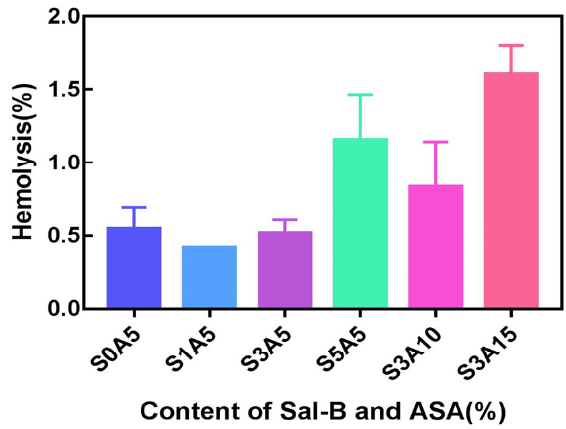
Figure 7. Haemolysis rate of the dual drug-loaded biomimetic composite scaffold.